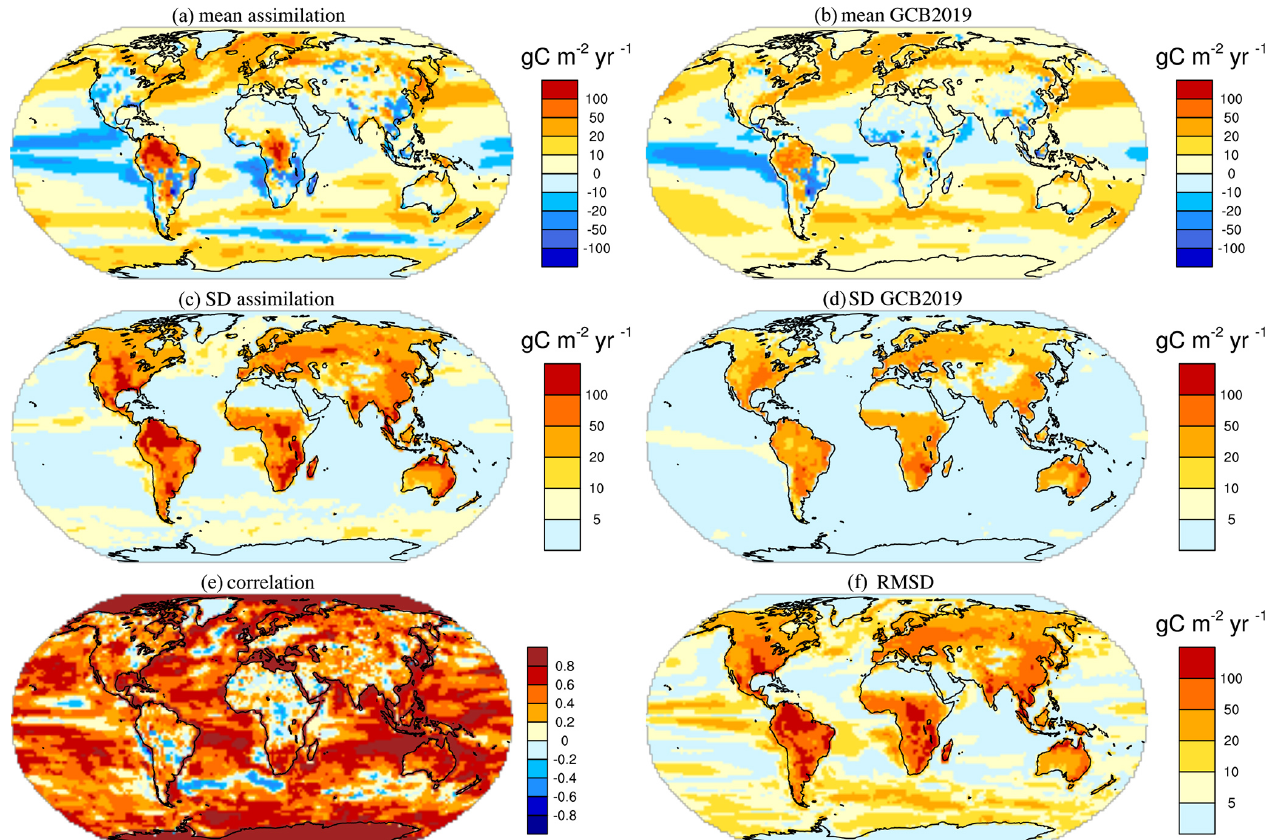
Figure 3. Spatial distribution of the CO 2 fluxes from model assimilations compared to GCB2019. Climatological mean CO 2 fluxes into the land and ocean from the atmosphere in assimilation (a) and Global Carbon Budget (GCB 2019, Friedlingstein et al., 2019) estimates (b) . Temporal variability, i.e., standard deviation, of CO 2 fluxes in the assimilation simulation (c) and GCB2019 (d) . Correlation and root-mean- square deviation (RMSD) between assimilation and GCB2019 are shown in (e) and (f) , respectively. The results are based on annual mean data for the time period 1970–2018. Positive values in (a) and (b) refer to CO 2 fluxes into the ocean or